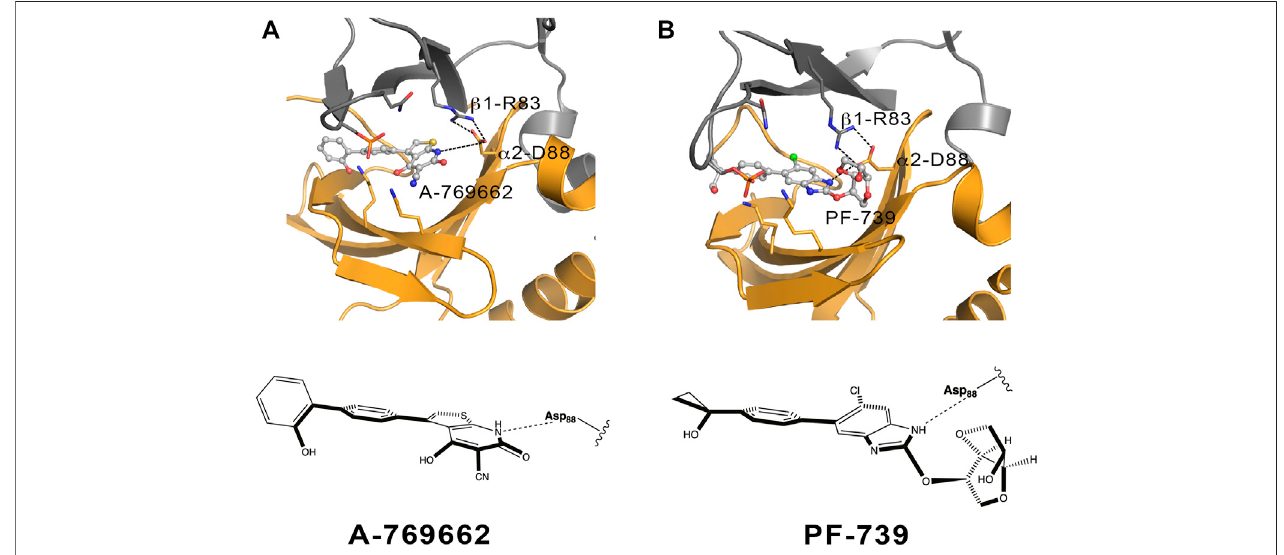
FIGURE11| Schematicrepresentationofthe α 2 β 1holostatefor (A) A-769662and (B) PF-739.The2Dchemicalstructureofthedirectactivatorsispresentedwith the orientation displayed in the ADaM site. The polar interactions between β 1-Arg83, α 2-Asp88 and the respective ligands are shown in dashed lines.